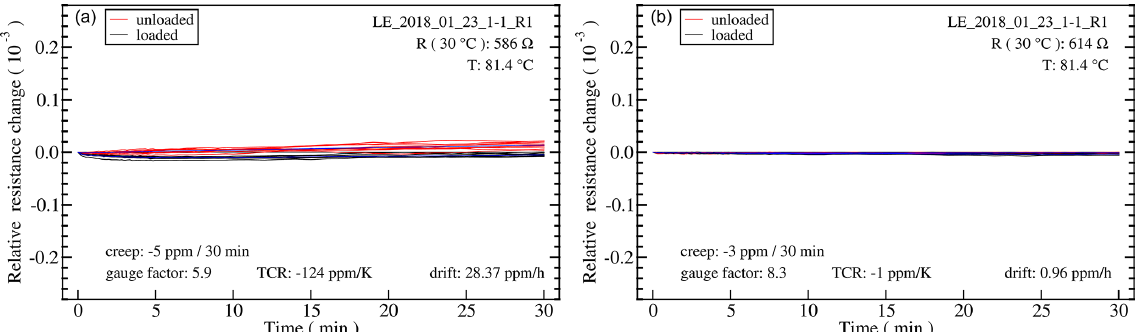
Figure 8. Creep measurements and drift values of Ni 50 Cr 50 -C films. (a) as-deposited (sample 3 initial ) (b) after annealing at 350 ◦ C per 5h + 450 ◦ C per 5h (sample 3 final